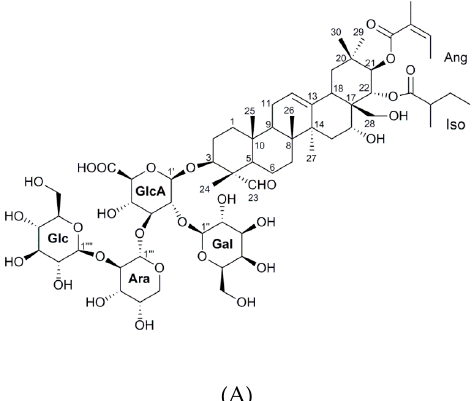
Molecules 2018 , 23 , x FOR PEER REVIEW 2 of 12 Figure 1. ( A ) Structure of oleiferasaponin A 2 ; and ( B ) Key HMBC correlations of oleiferasaponin A 2 .